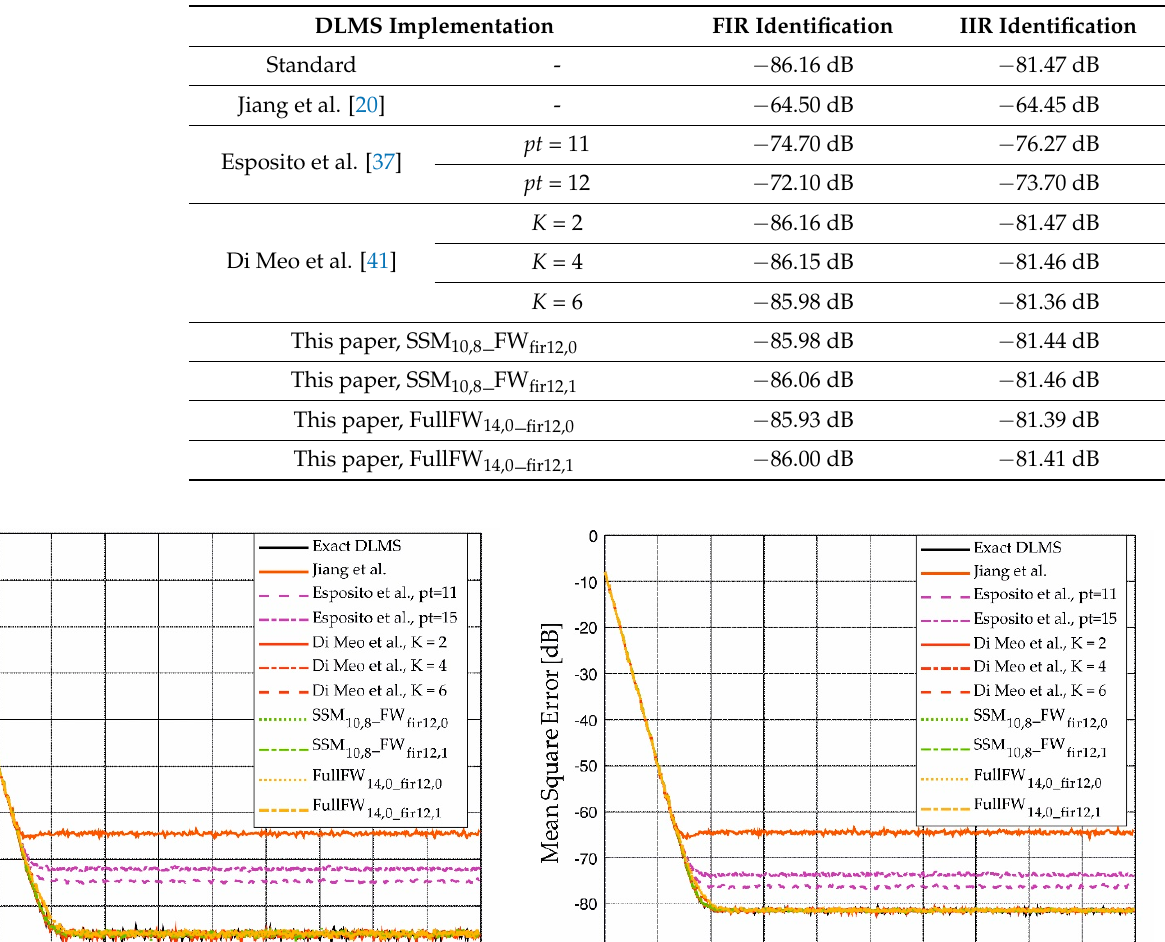
Table 2. Regime MSE with approximation in the FIR section.